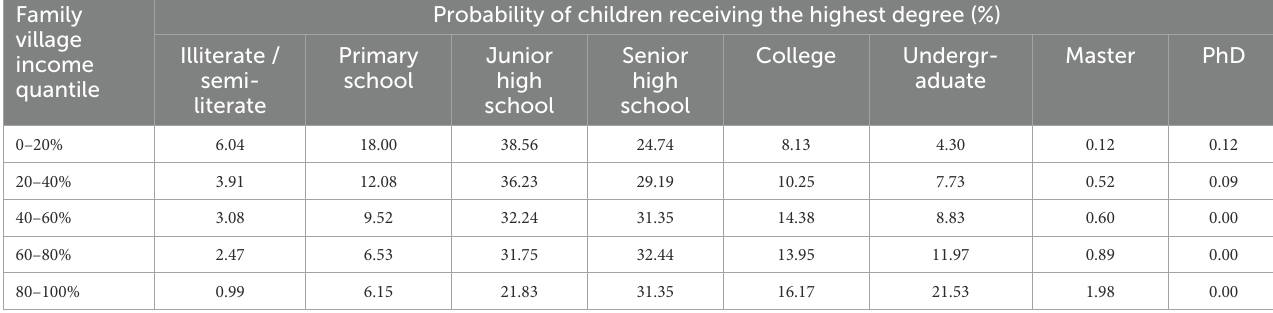
TABLE 3 Distribution of children’s education under different family